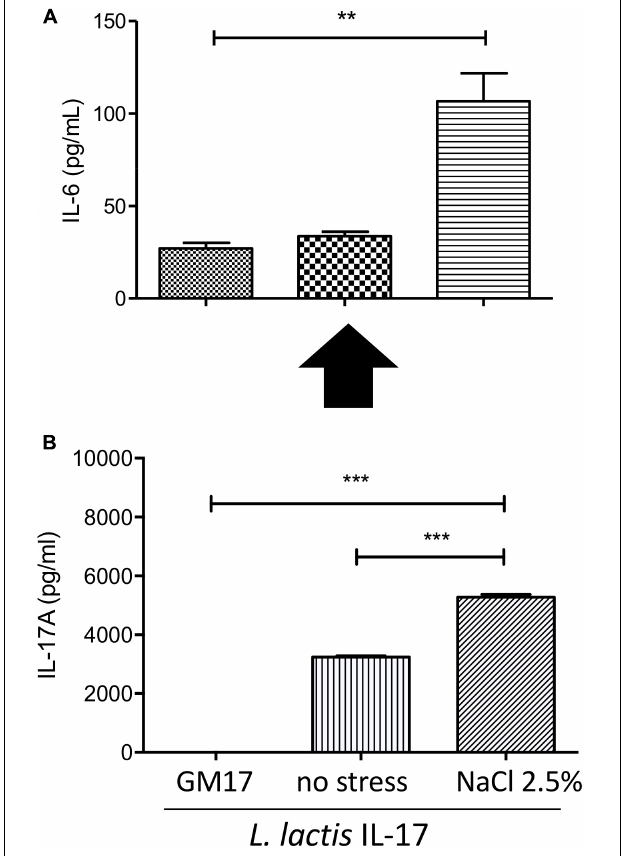
FIGURE 2 | Cellular-based bioassay for L. lactis -secreted bioactive IL-17. (A) IL-6 secretion by 3T3 L1 cells after exposure to supernatant samples of recombinant L. lactis . (B) Quantification of IL-17 production by recombinant lactococci by ELISA. Data are represented as mean ± SEM of two independent in vitro assays. GM17 was used a control for supernatant conditions. Stress was induced with NaCl 2.5%. Data were treated by ANOVA (Turkey